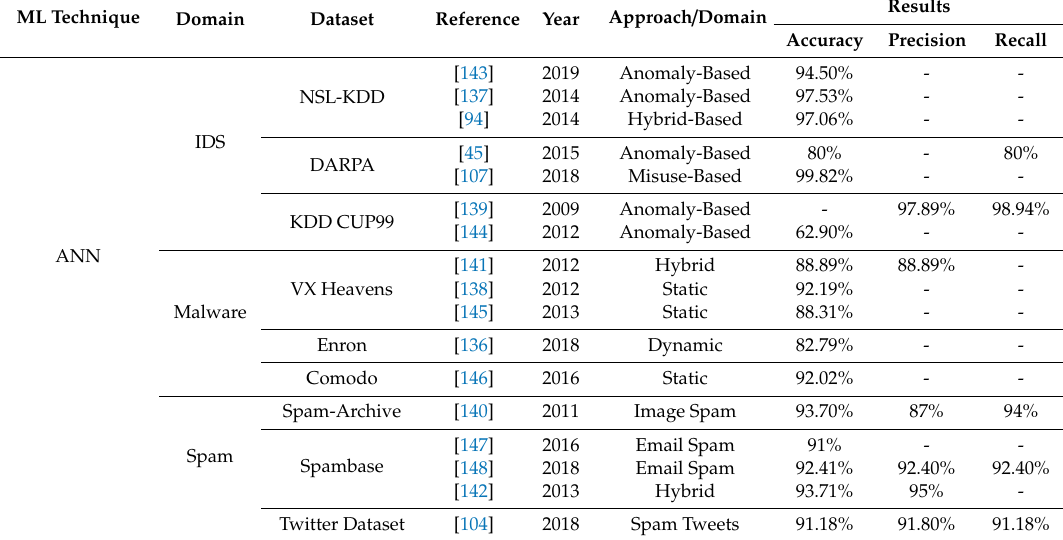
Table 7. Evaluation of ANN in